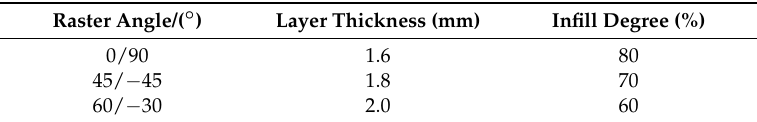
Table 2. The evaluated parameters of the printing process.